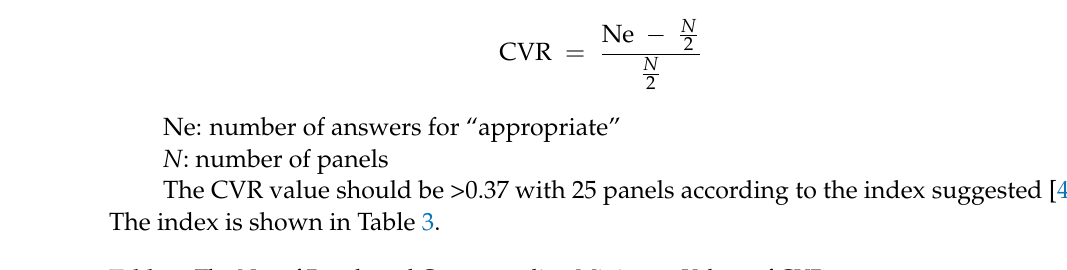
Table 3. The No. of Panels and Corresponding Minimum Values of CVR. The No. of